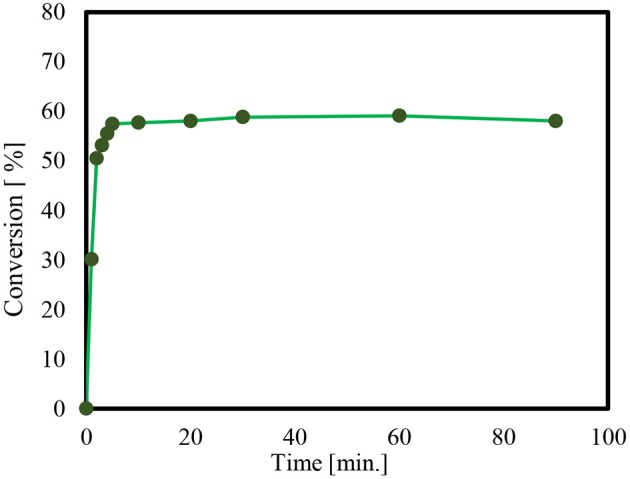
Reaction of glycerol and acetone using p-toluenesulfonic acid (PTSA), as a homogeneous catalyst, at 60°C.